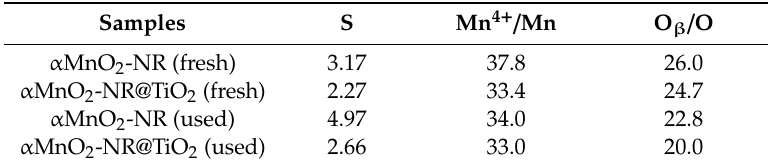
Figure 9. XPS spectra of ( a ) Mn 2p, ( b ) O 1s and ( c ) S 2p. Table 3. The surface atomic concentrations and the relative concentration ratios of samples based on XPS.